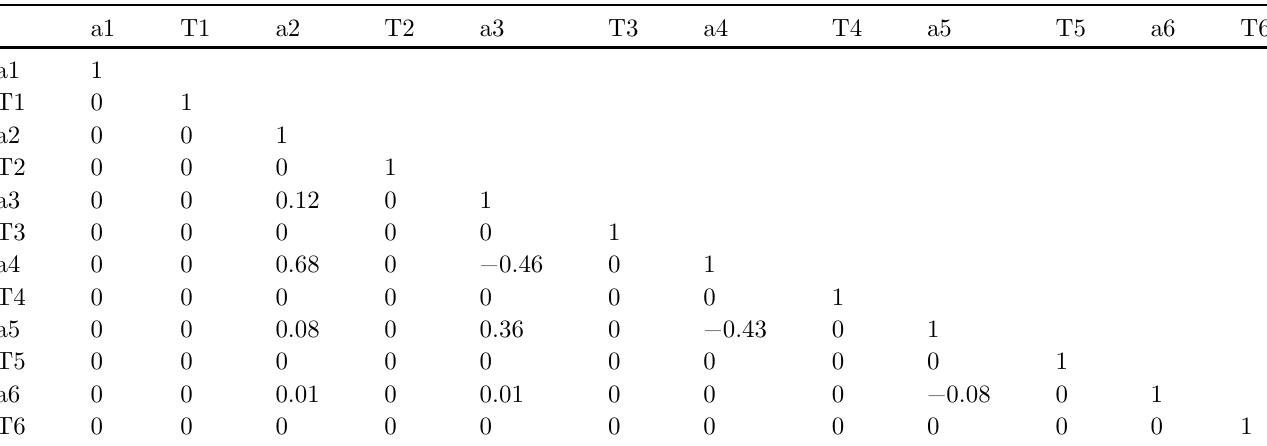
Table 14. Correlation matrix for the 6-group DN data set obtained for fast neutron induced fi ssion of 241 Pu.